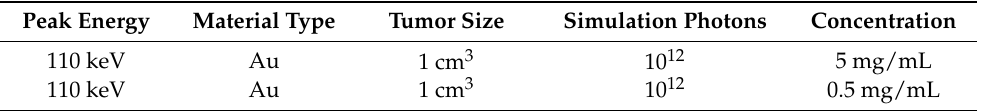
Table 2. Basic settings for simulation.